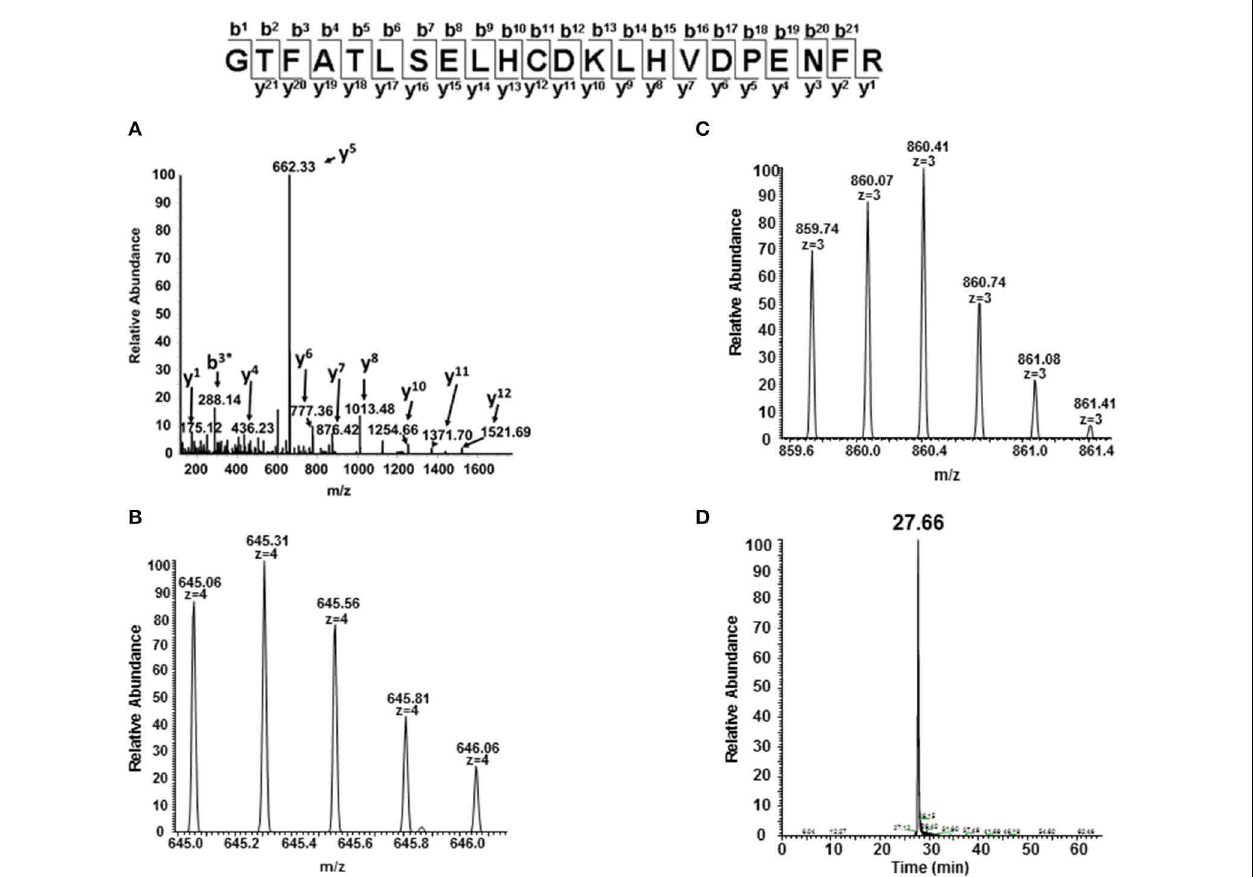
FIGURE 8 | MS/MS fragmentation spectrum and extracted ion chromatogram (XIC) of oxidized C93 tryptic peptide (residues 83–104). For quantitative experiments, all charged versions of Mascot identified peptides listed in Table 1 (containing the oxidized or unoxidized form) were selected in a similar manner as shown in this figure to quantify changes under different oxidative conditions. (A) Mascot identified MS/MS fragmentation spectrum of the oxidized C93 peptide GTFATLSELHCDKLHVDPENFR. (B,C) + 4 and + 3 charge state isotopic